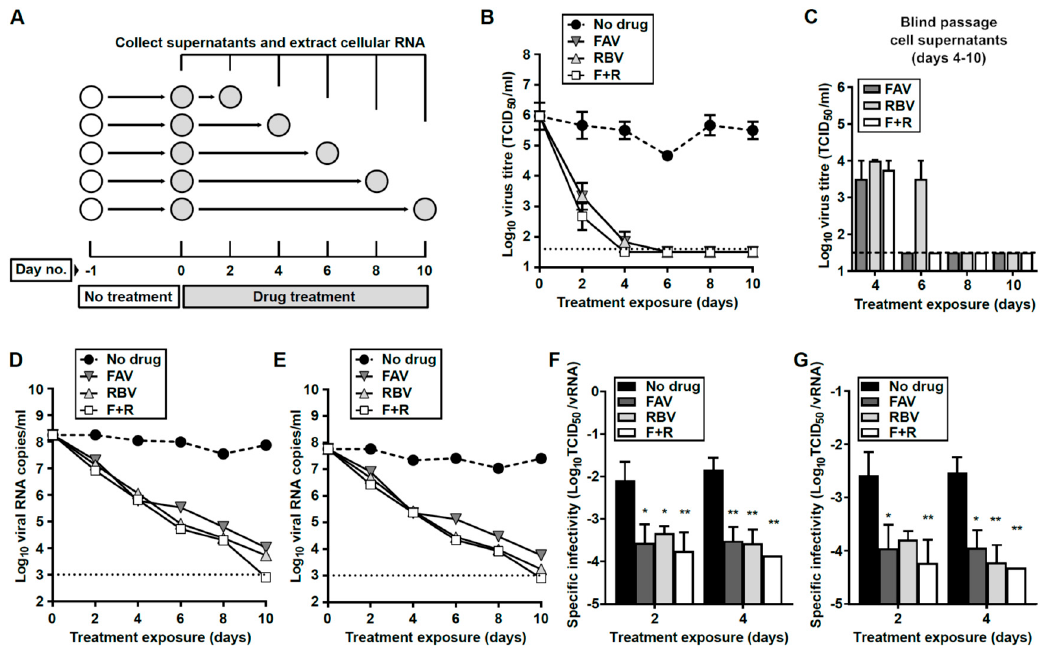
Figure 5. Treatment with FAV, RBV, or a combination of both can cause complete loss of infectivity in cell supernatants. ( A ) Schematic representation of the experimental procedure. For each treatment, six independent monolayers of S p39 cells were seeded ( n = 6). Whole monolayers (RNA extraction) and supernatants (RNA and virus titers) of untreated or treated cells were collected at days 2, 4, 6, 8, and 10 ( n = 1). ( B ) Virus infectivity in S p39 cells treated with FAV, RBV, or a cocktail of both drugs (F + R) at 2000 µ M each drug. A dotted line represents the limit of detection. ( C ) Virus titers recovered after a blind infection in naïve Vero cells using 100 µ L of S p39 cell supernatants obtained in B after treatment. Those samples containing undetectable virus levels (dashed line) remained negative when two additional blind passages in Vero cells were performed (not shown). ( D , E ) Viral RNA levels in the supernatants of treated cells, using qPCR methods based on the detection of NS5- (D) and Env-coding regions ( E ). ( F , G ) Specific infectivity (SI) of USUV genomes detected in the cellular supernatants of treated cells. SI is calculated as the ratio of infectious units ( B ) to viral RNA molecules ( D and E ). SI based on qPCR methods for the detection of NS5 ( F ) or Env ( G ) genes.